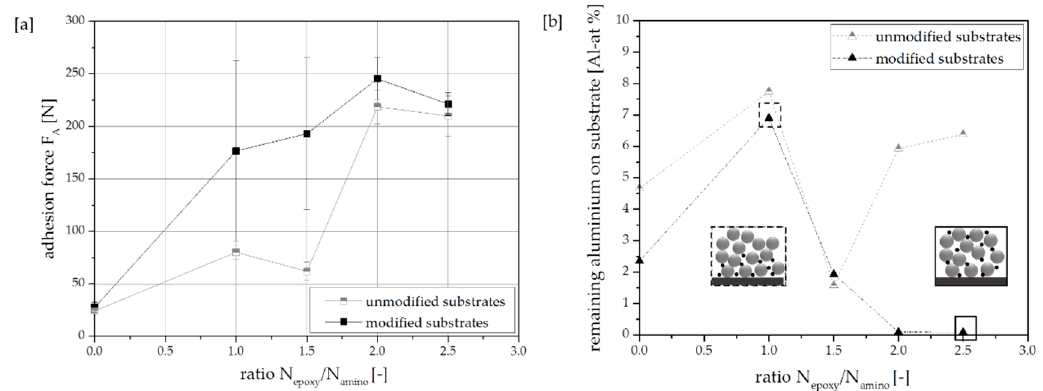
Figure 6. Measured adhesion forces ( a ) and remaining aluminium content ( b ) of coatings on unmodified and modified substrates.